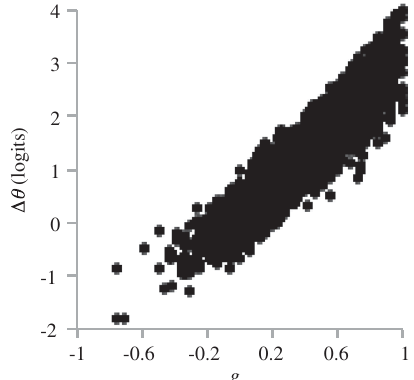
FIG. 9. Δ θ versus g for all 3205 students in the LSCI national data